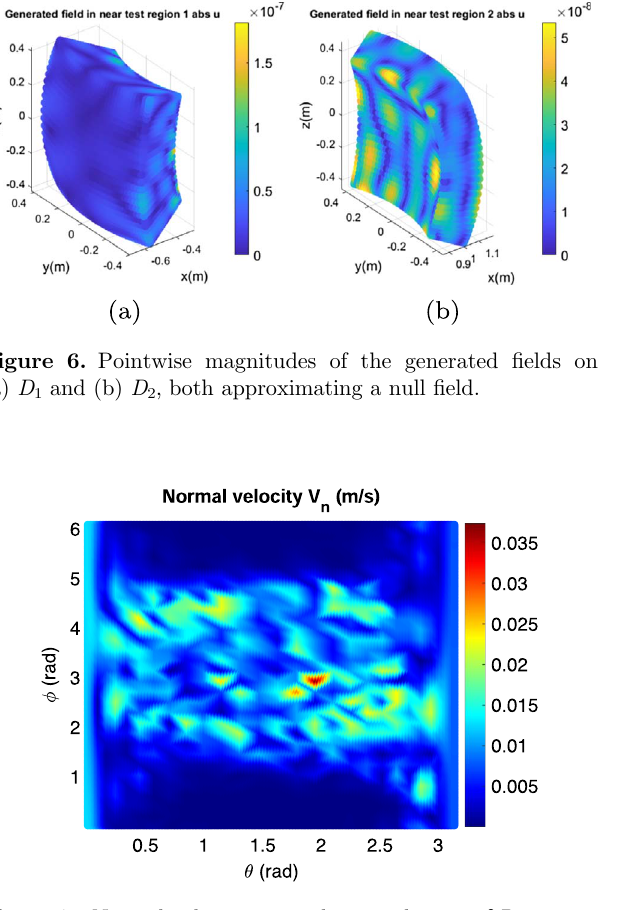
Figure 7. Normal velocity v n on the actual source o D a .